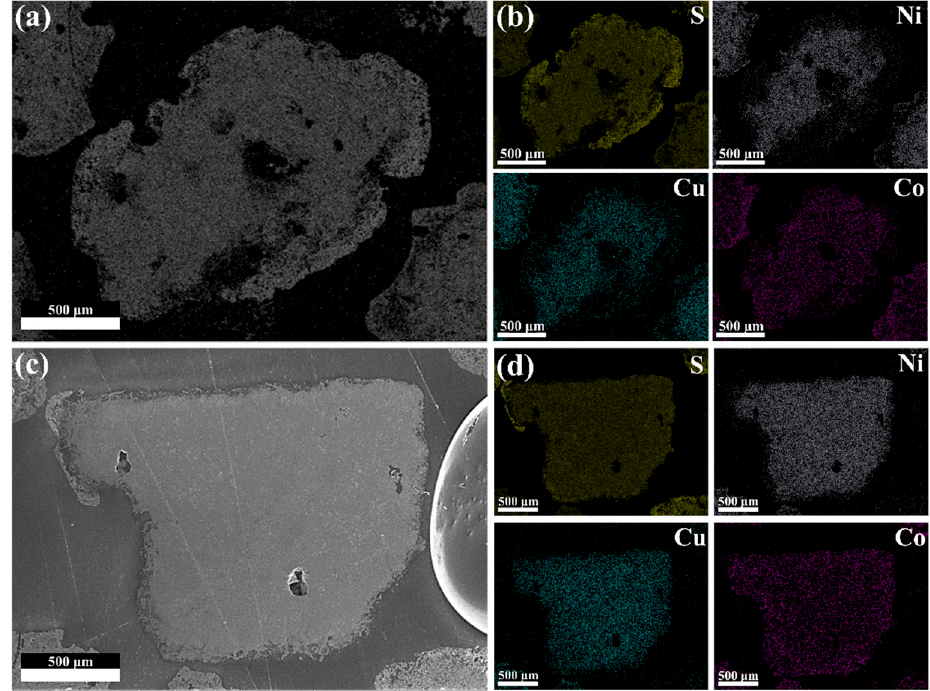
Figure 7. ( a , c ) SEM images of low-nickel matte after 1 and 2 h leaching, respectively; ( b , d ) EDS analyses for the selective areas from ( a ) and ( c ),